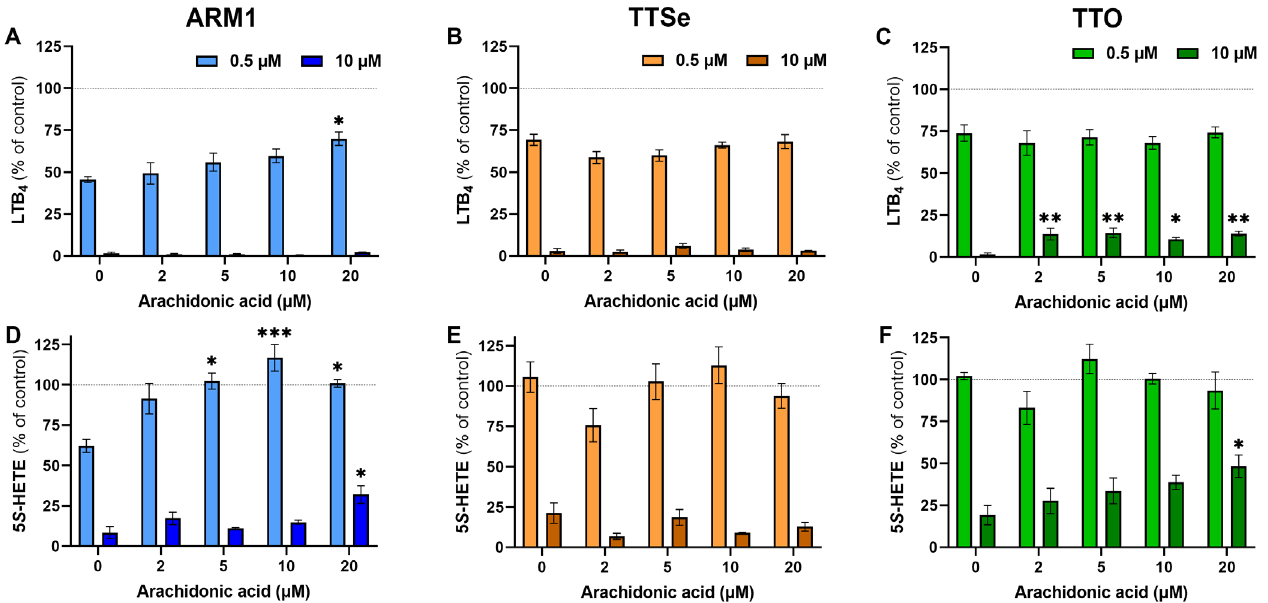
Figure 3. The effect of arachidonic acid at different concentrations on the potency of inhibitors. ( A – C ) The levels of LTB 4 were determined from intact PMNs treated with 0–20 µM of arachidonic acid in the presence of 0.5 µM or 10 µM of ARM1, TTSe or TTO. ( D – F ) The levels of 5 S -HETE were determined in parallel. Statistically significant values were derived in comparison with the control value in the absence of exogenous AA. * p value < 0.05; ** p value < 0.01; *** p value < 0.001; non-significant differences are not